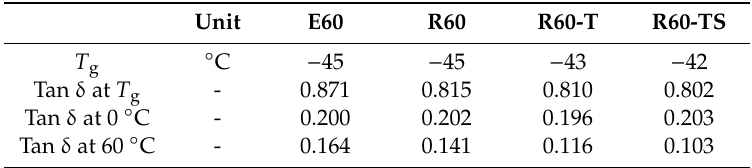
Figure 12. Temperature-dependent tan δ of vulcanizates of emulsion styrene butadiene rubber (ESBR) and reversible addition-fragmentation radical transfer (RAFT) ESBR carbon black-filled compounds with a controlled cure system. Table 10. Viscoelastic properties of vulcanizates of emulsion styrene butadiene rubber (ESBR) and reversible addition-fragmentation radical transfer (RAFT) ESBR carbon black-filled compounds with a controlled cure